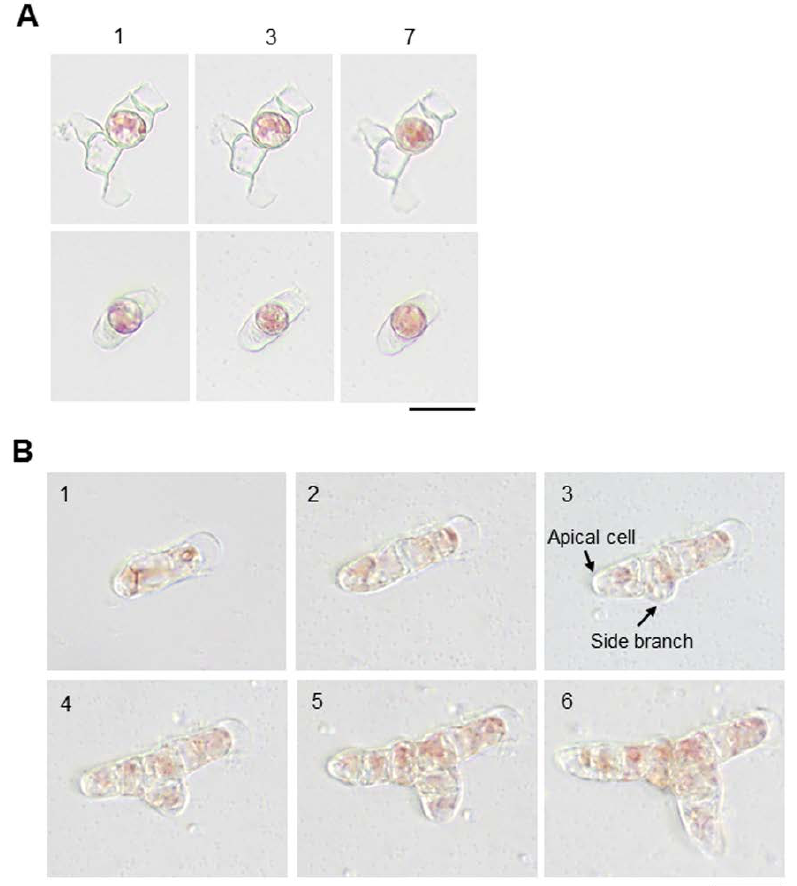
Figure 4. Differences in growth and side branch formation by single differentiated and apical cells from conchosporangia. ( A ) Single differentiated cells are unable to grow. Upper and lower panels